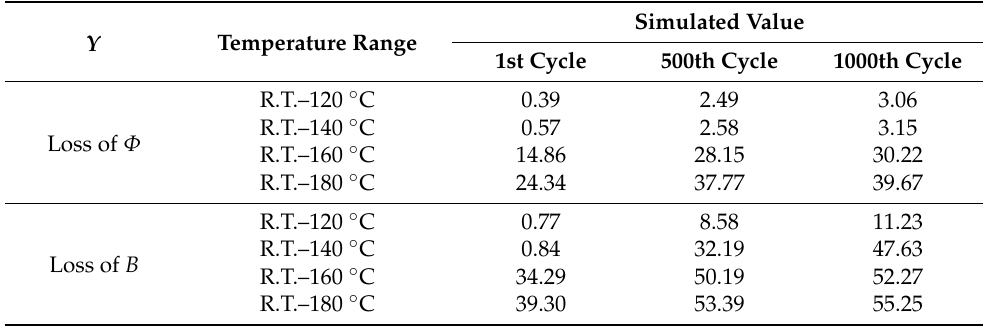
Table 3. Simulation results of the losses of Φ and B in different temperature ranges after the 1st, 500th, and 1000th cycles by using the fitting parameters as shown in Table